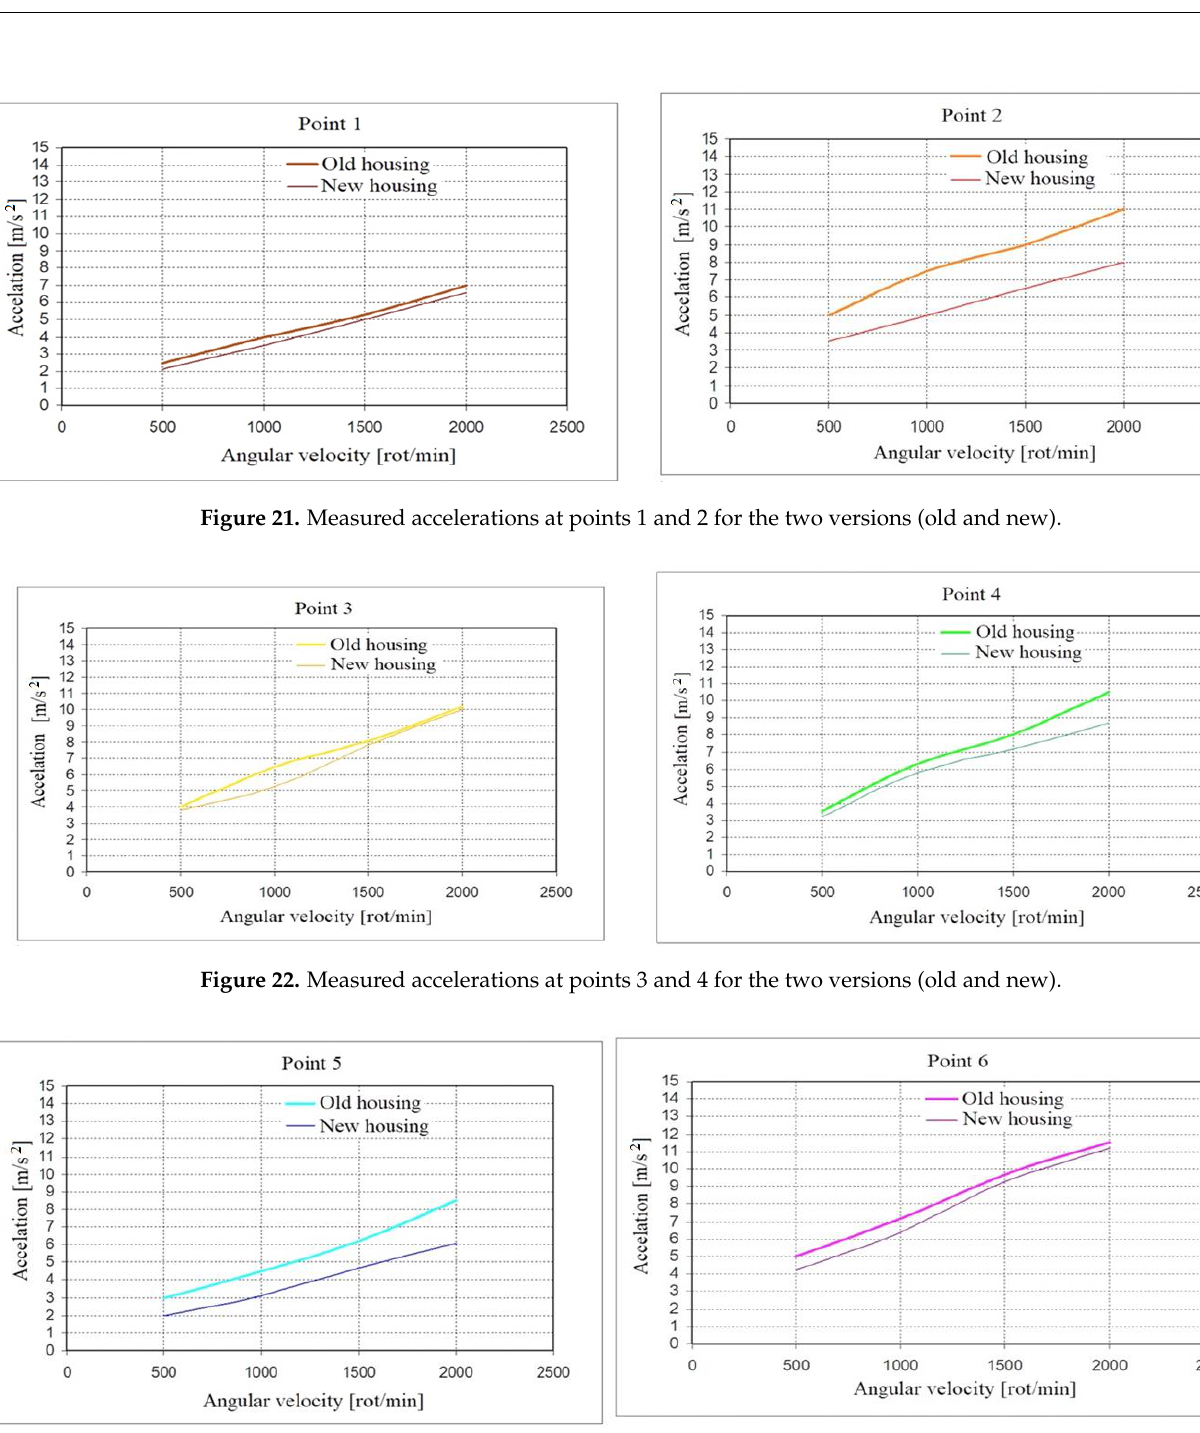
Figure 23. Measured accelerations at points 5 and 6 for the two versions (old and new).